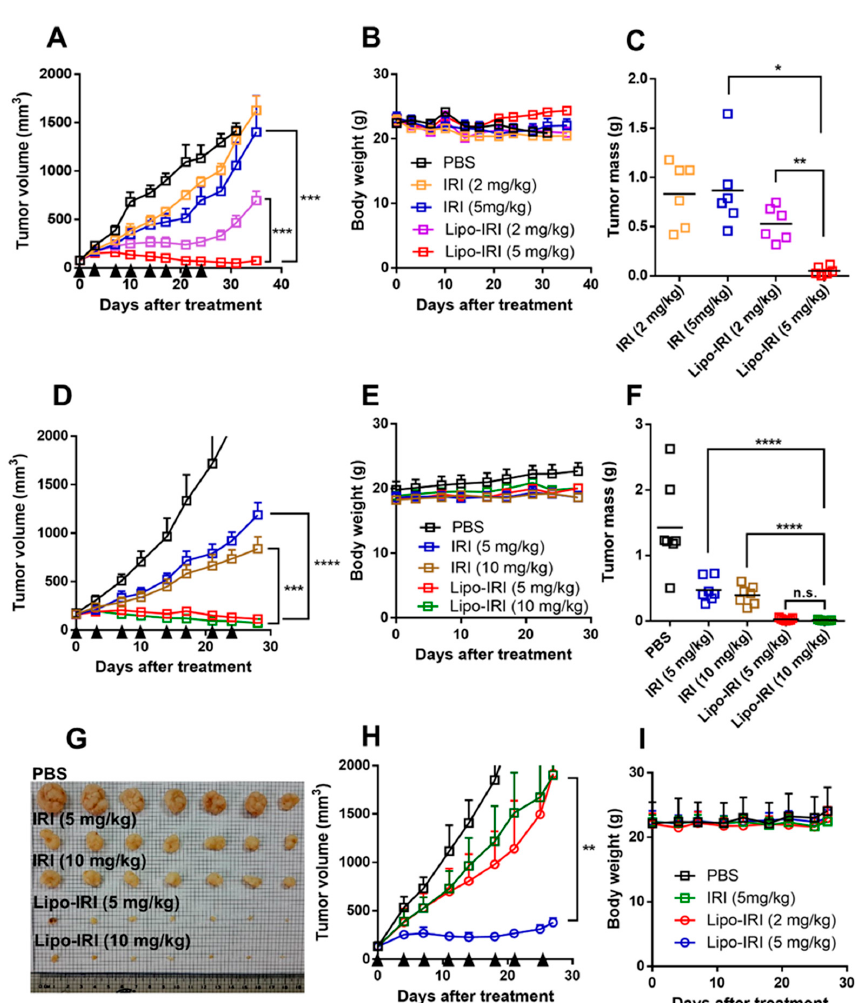
Figure 4. Lipo-IRI effectively reduced tumor volume and mass in colorectal cancer (CRC) xenograft models. HCT 116 ( A – G ) or SW620 ( H , I ) tumor-bearing mice received i.v. doses (arrows) of PBS, IRI or Lipo-IRI (2 or 5 mg/kg) twice per week. In the HCT 116 model, ( A ) the tumor volume and ( B ) body weight were monitored during the treatment. ( C ) The tumor mass was measured